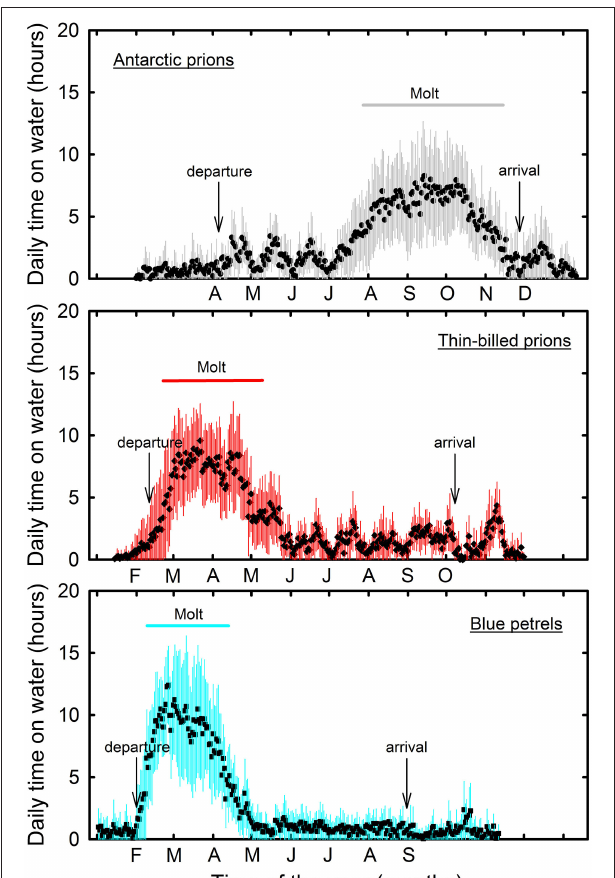
FIGURE 1 | Daily time spent sitting on the water as a proxy of daily activity patterns of Antarctic (gray) and thin-billed (red) prions and of blue petrels (blue) over the annual cycle. Molt refers to the period during which birds spent > 50% time per day sitting on water. Months refer to the species-specific inter-breeding period. Birds were equipped with miniaturized saltwater immersion geolocators. Values are means ±